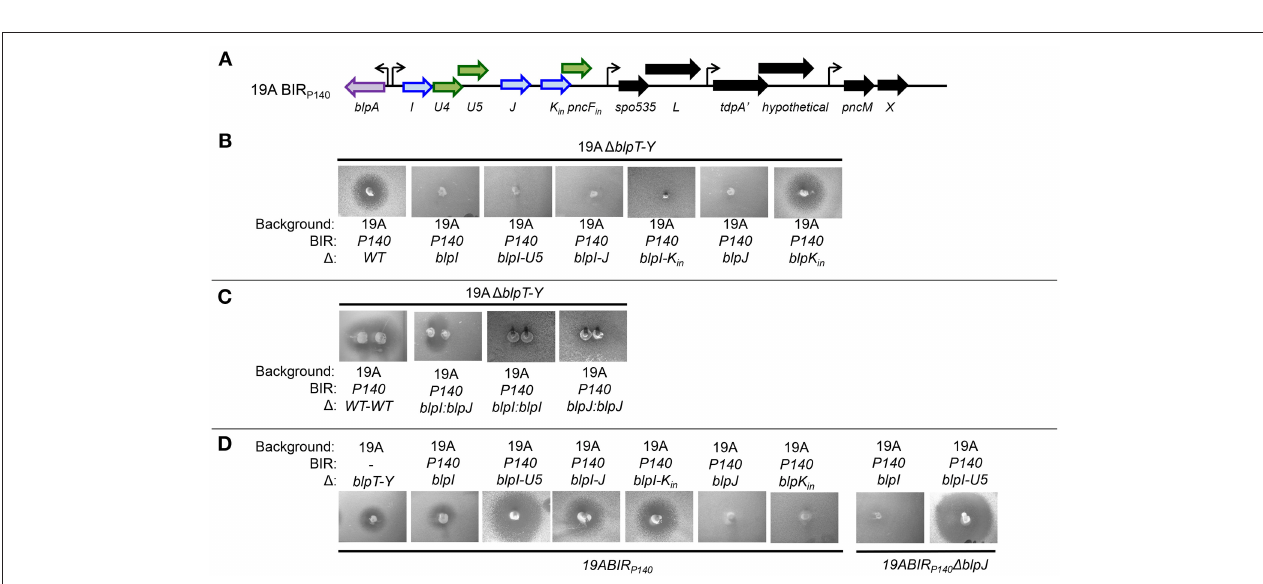
FIGURE 2 | Functional analysis of the BIR region of P140 strain after moving into a 19A strain background. (A) Schematic representation of BIR P140 . Blue arrows indicate predicted pneumocins and green arrows indicate predicated immunity proteins. Black arrows indicate ORF encoding proteins of unclear significance. Curved arrows represent predicted transcriptional start sites based on the presence of a predicted BlpR binding site. (B–D) Agar overlay assays showing inhibitory and immune phenotypes. The properties of strains spiked into the plate are shown below the photo, overlay strains designations are shown above the